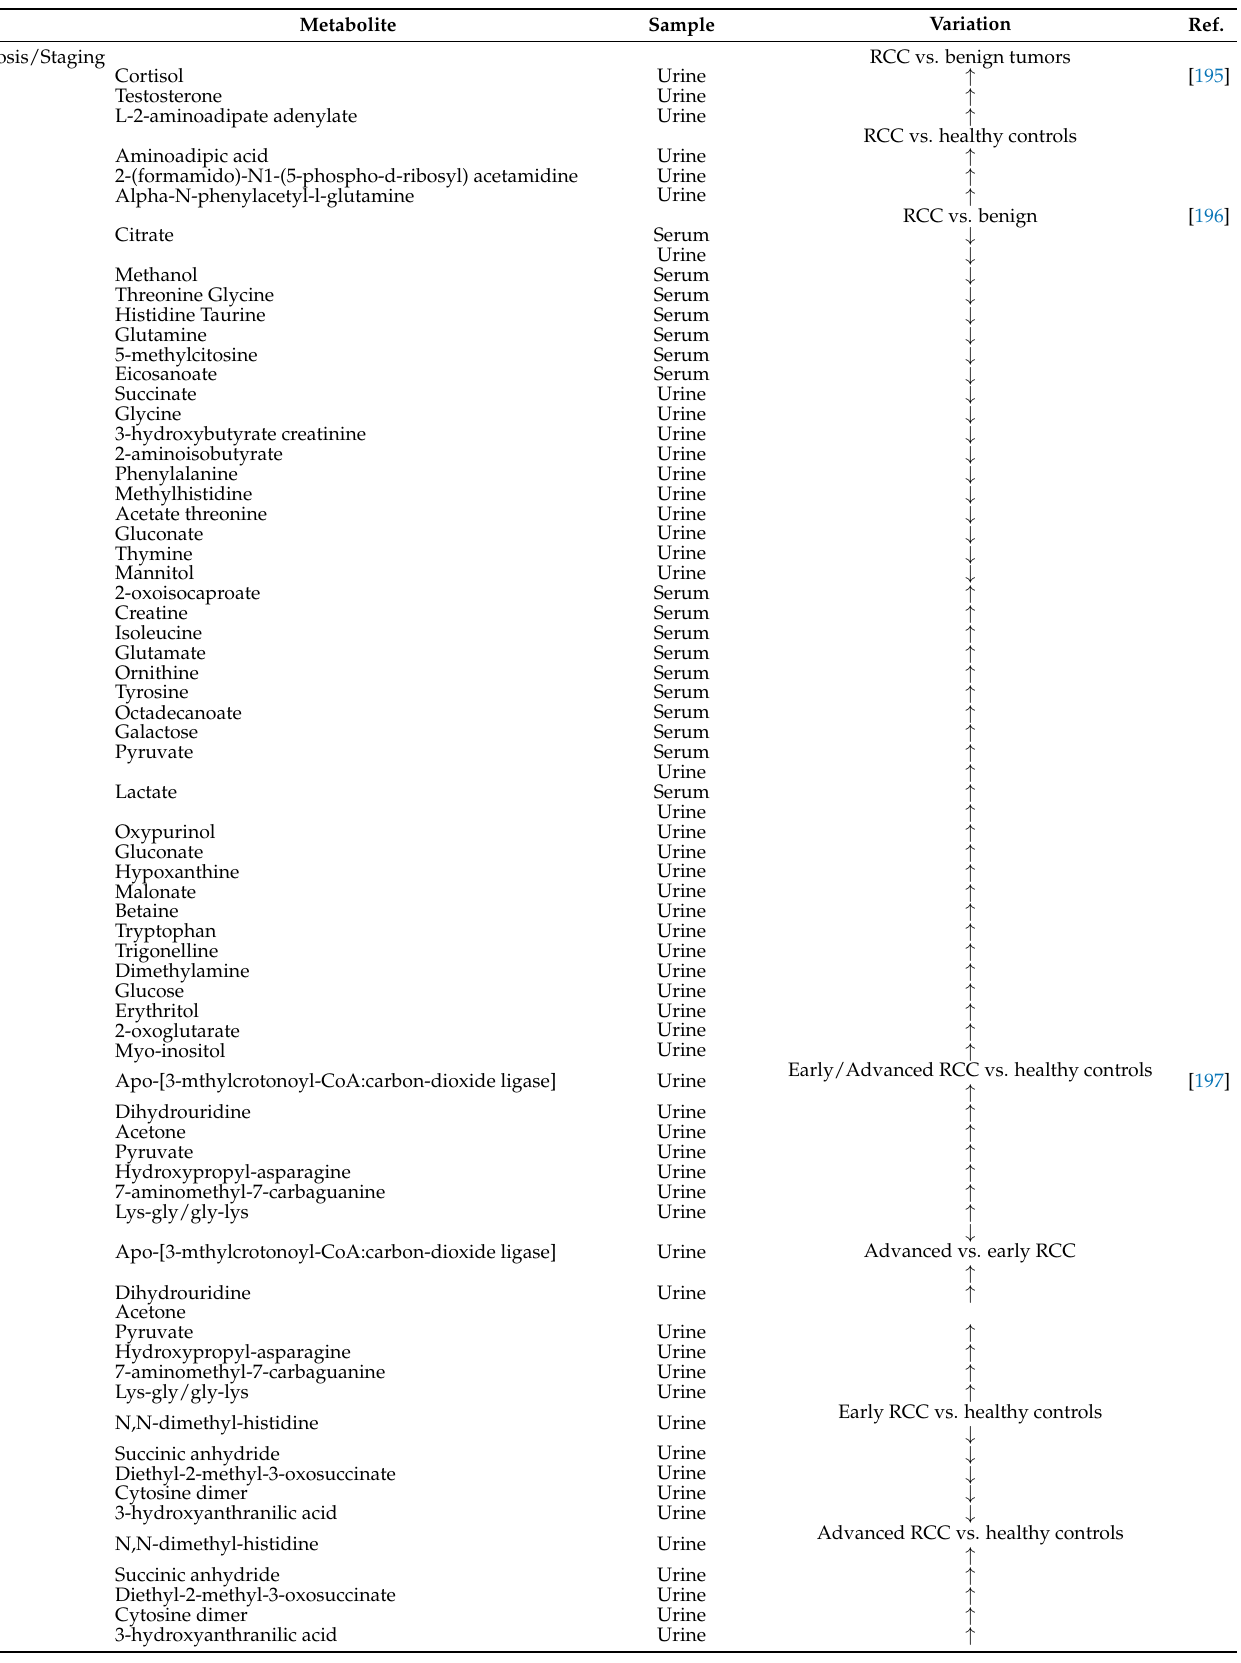
Table 2. Summary of potential biomarkers in RCC staging and drug efficacy